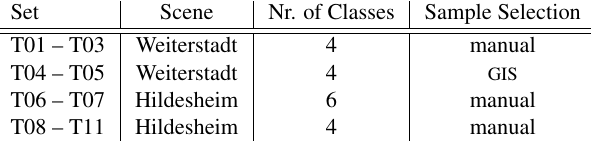
Table 1: Training data sets from Weiterstadt/Germany and Hildesheim/Germany. Sample selection for two scenes was au- tomatically done using a GIS .